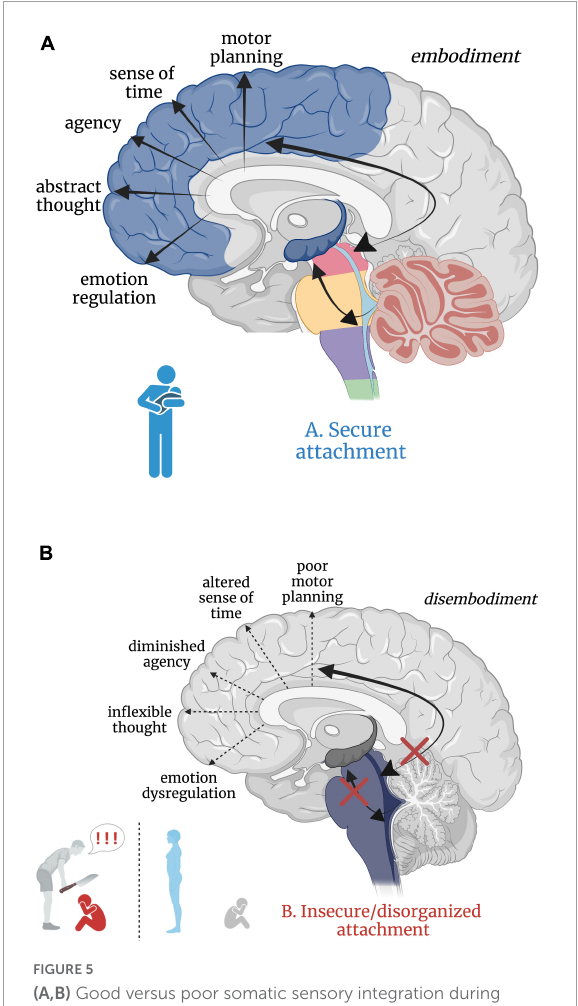
FIGURE5 (A,B) Good versus poor somatic sensory integration during development with a secure versus insecure attachment figure, respectively. (A) Healthy brainstem level multisensory integration as a result of attuned, nurturing, somatic sensory-rich caregiving provides the foundation for higher-order limbic and cortical capacities. (B) An overwhelmed or malnourished brainstem due to abusive or neglectful caregiving. The child does not receive comforting touch or attuned rhythmical movement with a safe affective caregiver. Somatic sensory experiences are paired with unsafe or insecure attachment relationships, which has cascading aversive effects on higher-order limbic and cortical